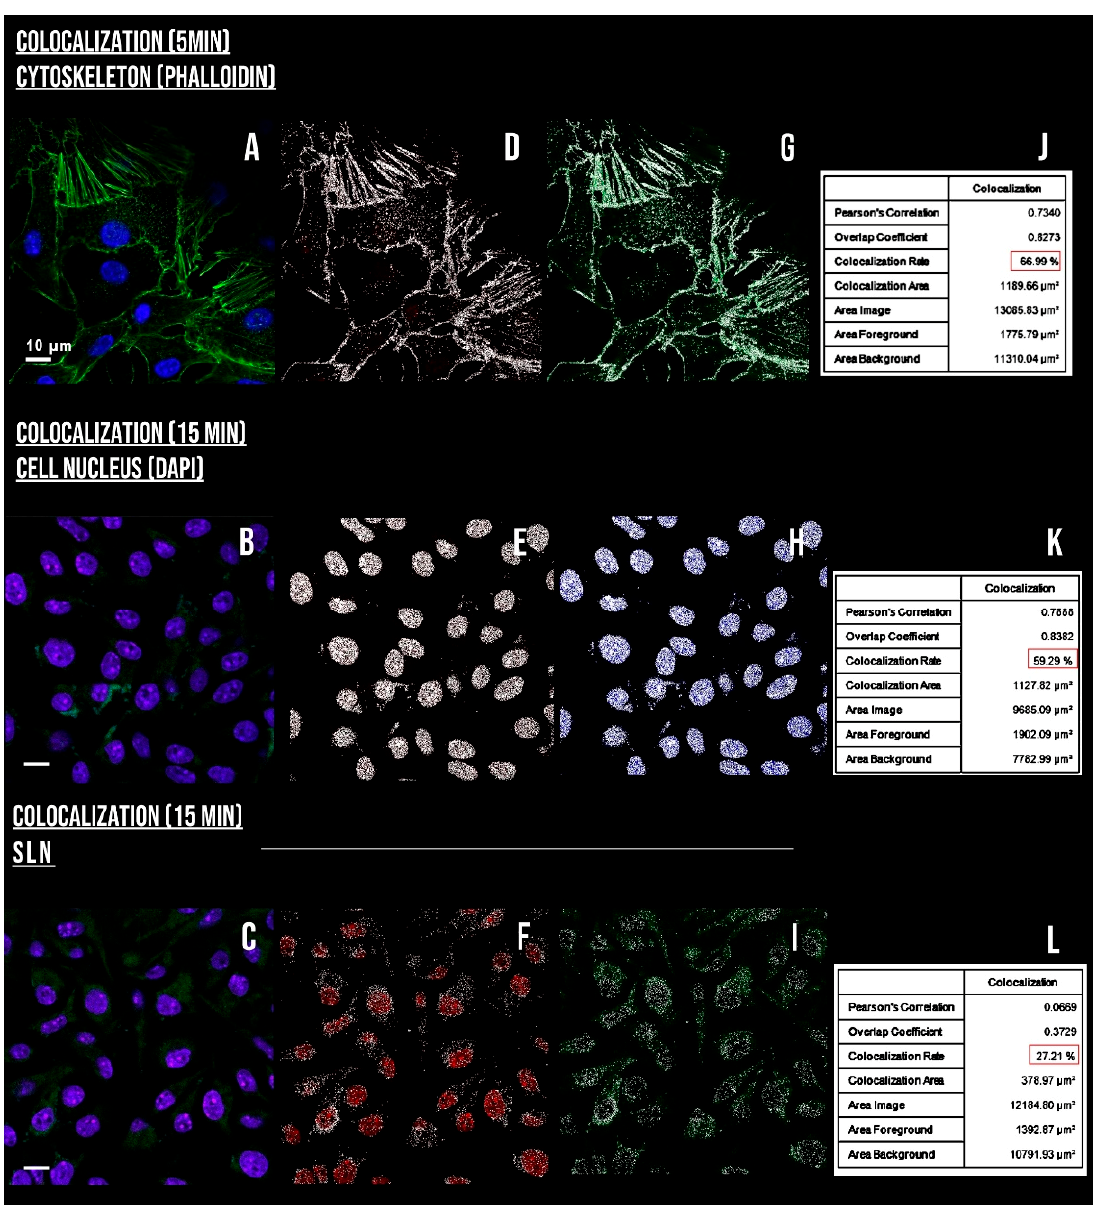
Figure 11. Colocalization assays of SLN-AlPc. The figure shows the colocalization of fluorescence relative to AlPc for cytoskeleton ( A , D , G and J ), nucleus ( B , E , H and K ), and fluorescence relative to SLN-AlPc ( C , F , I and L ). The white dots in the figures represent positive fluorescence pixels, indicating colocalization. In the last column, the colocalization index is shown in %, in addition to the Pearson coefficient that was used for the analyses.